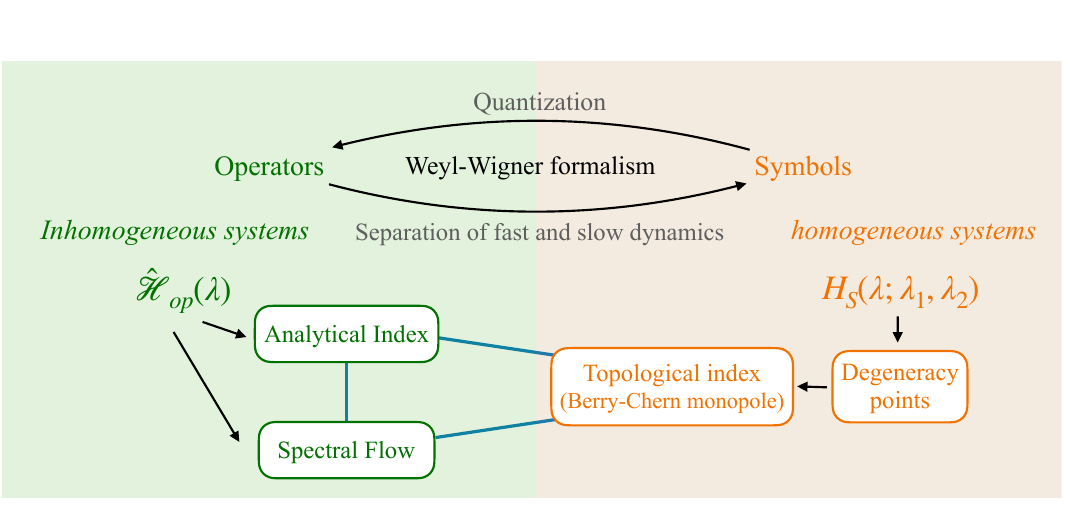
Figure 10: Quick overview of the general structure of the theory of the monopole- spectral flow correspondence. The blue lines represent an equality